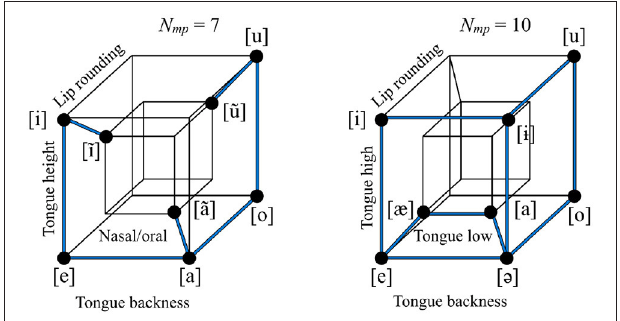
FIGURE 2 | The vowel inventories of Umbundu (left) vs. Bukiyip (right). The two inventories have the same size and number of non-redundant features (and therefore degree of economy), but differ in how many oppositions they have, that is, pairs of sounds that are distinguished only by one feature dimension, shown as dark blue lines (seven vs. ten). The vowel inventory of Bukiyip thus has higher local symmetry than that of Umbundu.